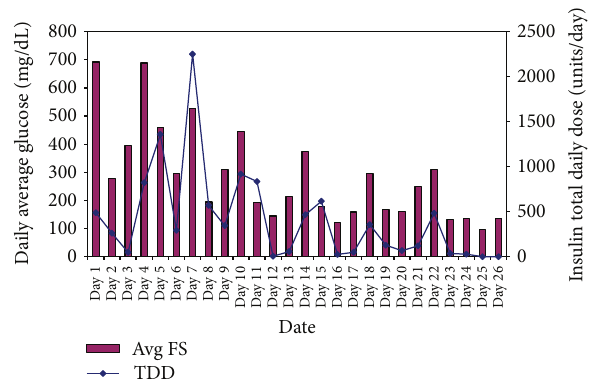
F 1: Daily average �ngerstick (FS) blood glucoses in mg/dl and insulin total daily dose (TDD) in